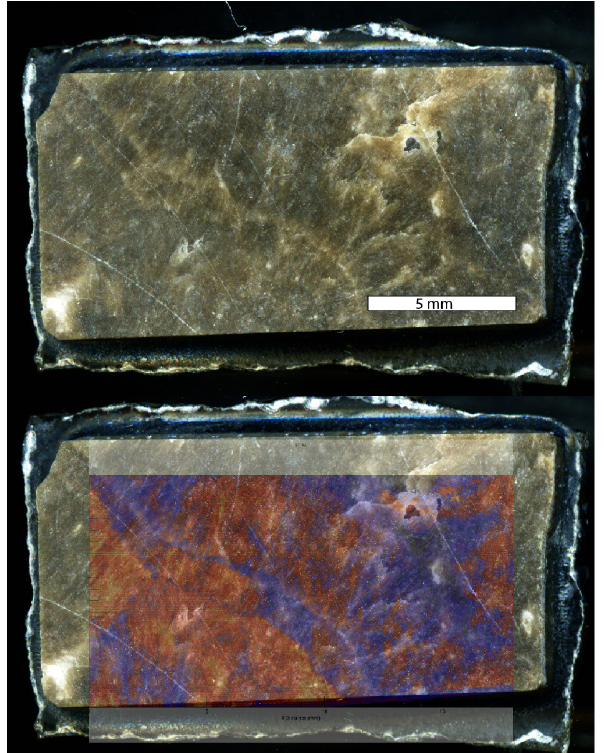
Figure 5. Synchrotron XRF Sr maps from beamline X26A NSLS Brookhaven National Lab overlain on the slab that was imaged. This XRF map was accomplished by on-the-fly scanning. To obtain U maps, we would have had to scan the same area above and below the binding energy for U and make a difference map because the SrK α peak is so large that the shoulder overlaps with the far less abundant UL 3 peak. However, based on the wealth of background information, we know that Sr is lost before U, and thus focusing on botryoids with elevated Sr should produce the best areas for LAcarb reference material. This type of image can be registered for laser ablation so that only the most favorable areas are used as a reference material.